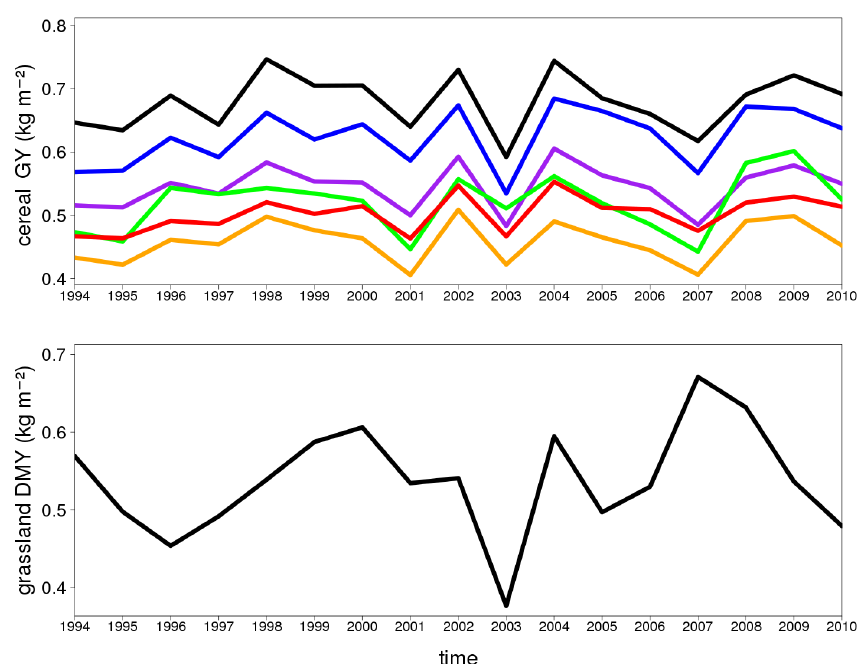
Figure 2. Averaged annual statistics of Agreste over the 1994-2010 period of (top panel) grain yields of six cereals (winter wheat in black, rye in red, winter barley in blue, spring barley in green, oat in orange and triticale in purple) over the 45 départements of Fig. 1 and (bottom panel) dry matter yields of permanent grasslands over the 48 départements of Fig. 1.